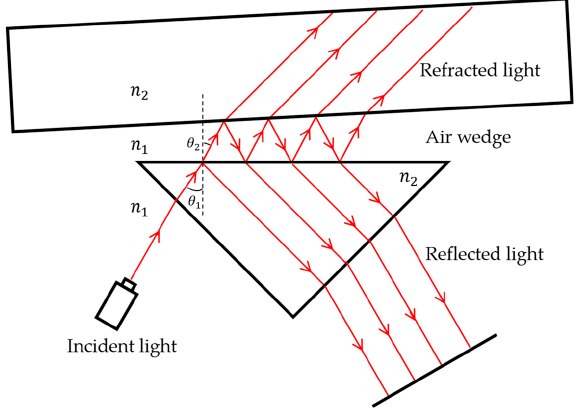
Figure 6. Schematic diagram of the multi-beam interference.